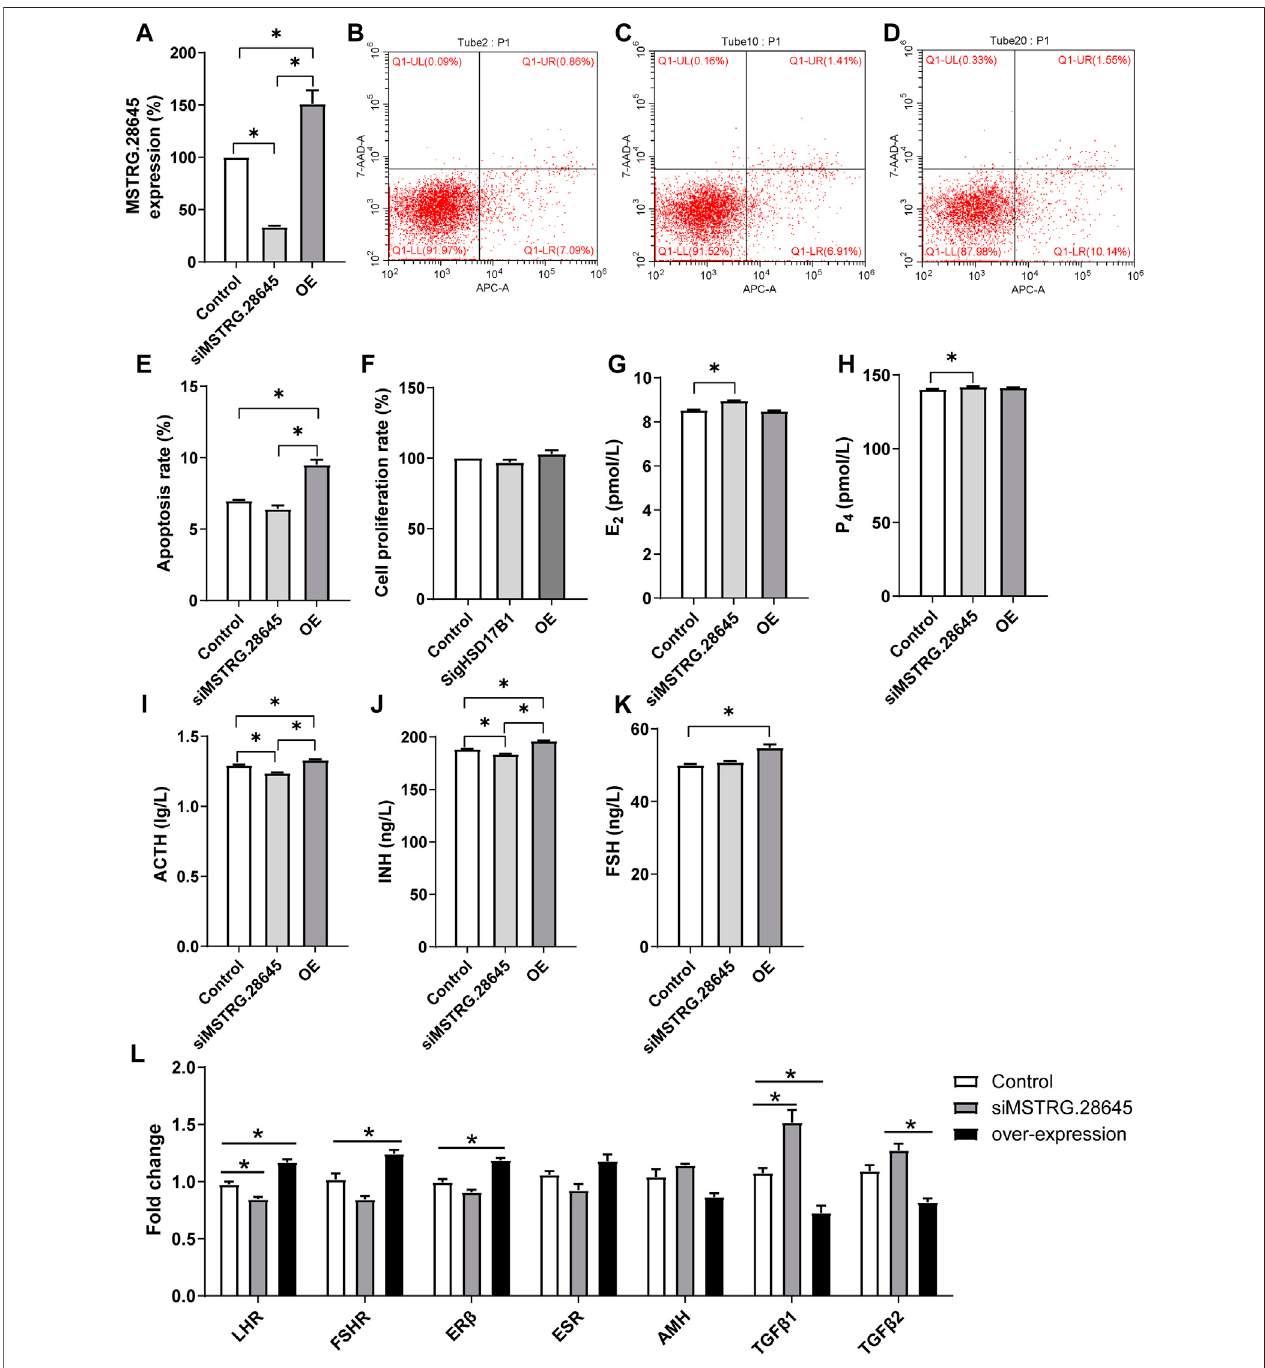
FIGURE6| Functionalveri fi cationofMSTRG.28645ingranulosacells. E2,estradiol;P4,progesterone; ACTH, adrenocorticotropic hormone;INH, inhibin-B;FSH, follicle-stimulating hormone; OE, overexpression. * p < 0.05; ** p < 0.01. The data are expressed as mean ± SD. (A) . Relative expression of MSTRG.28645 in granulosa cells after over expression and interference treatment. (B – D) The results of fl ow cytometry apoptosis in control, siRNA interference group, and overexpression group, respectively. (E, F) The statistical results of apoptosis rate and cell proliferation rate, respectively. (G – K) The level of E2, P4, ACTH, INH, and FSH, respectively. (L) Effect of MSTRG.28645 on gene expression in granulosa cells. Mult, Small Tail Han sheep (multiple births), n (cid:1) 3; Sgl, Xinji Fine Wool sheep (singleton), n (cid:1) 3.